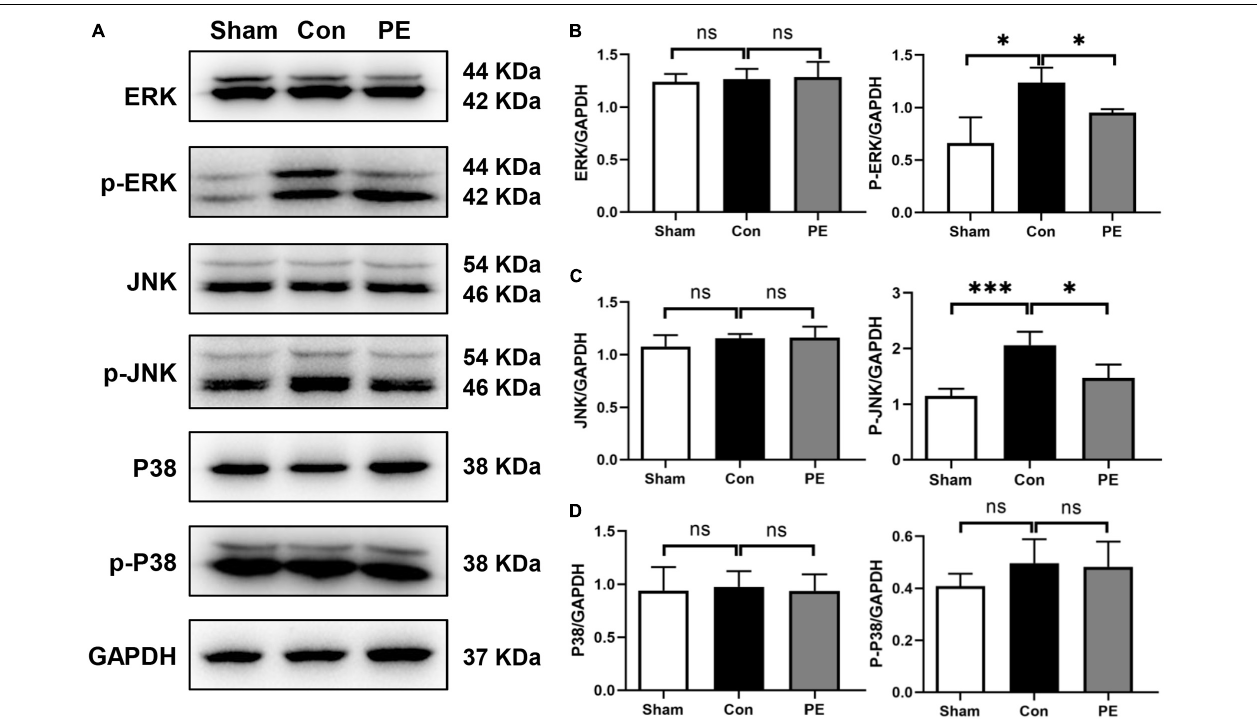
FIGURE 6 | Physical exercise inhibited ERK and JNK phosphorylation. (A) Representative images for western blotting of ERK, p-ERK, JNK, p-JNK, P38, and p-P38 expressions. (B–D) Densitometry analyses of the expression of ERK, p-ERK, JNK, p-JNK, P38, and p-P38 normalized to GAPDH. n = 5. Experimental data are expressed as the means ± SD. ∗ P < 0.05, ∗∗∗ P < 0.001.